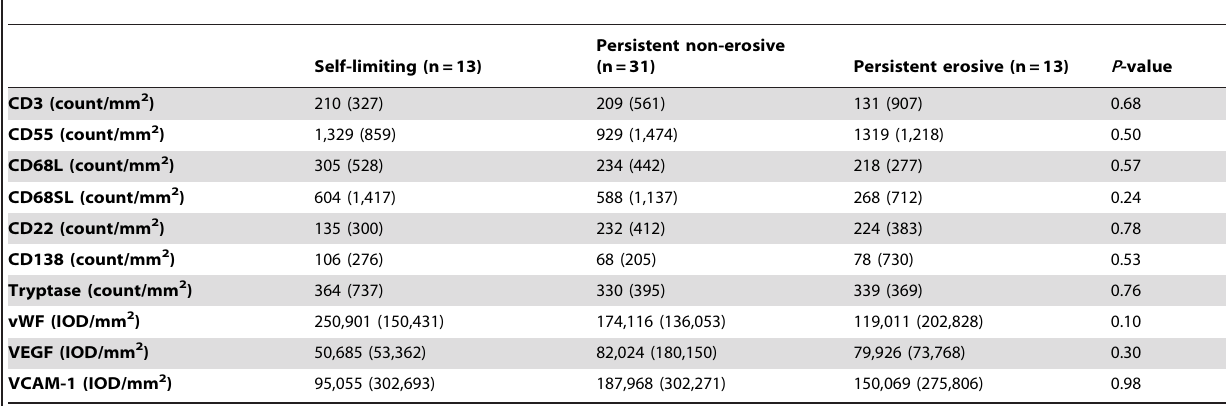
Table 4. Expression of phenotypic and vascular markers in synovial tissue of RA patients with self-limiting, persistent non-erosive or persistent erosive